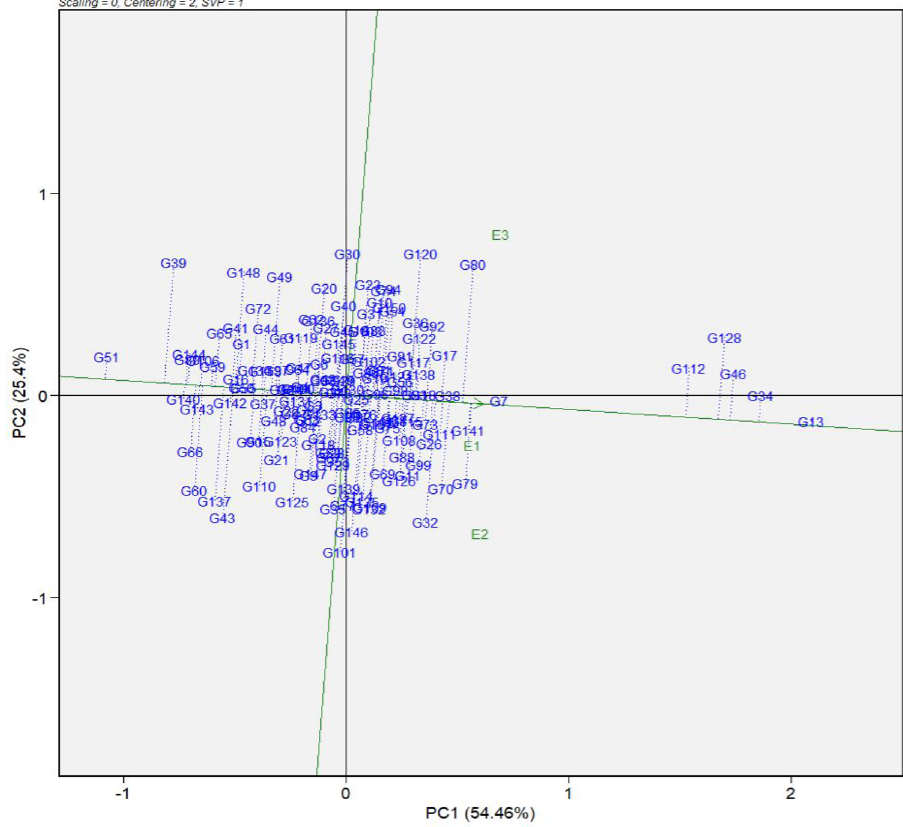
Figure 1. Mean performance versus stability pattern of the genotype main effects plus genotype × environment interaction (GGE) biplot based on the sensory mealiness data of 150 cassava genotypes grown in three environments in Nigeria. Environment names are coded as: E1, Igbariam; E2, Otobi; E3, Umudike. G1-G150 are genotypes defined in Supplementary Table